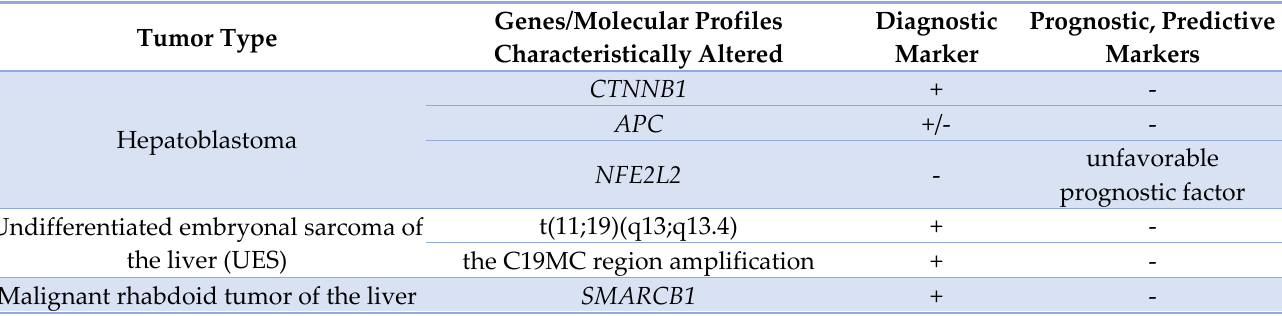
Table 6. Molecular markers of liver tumors.